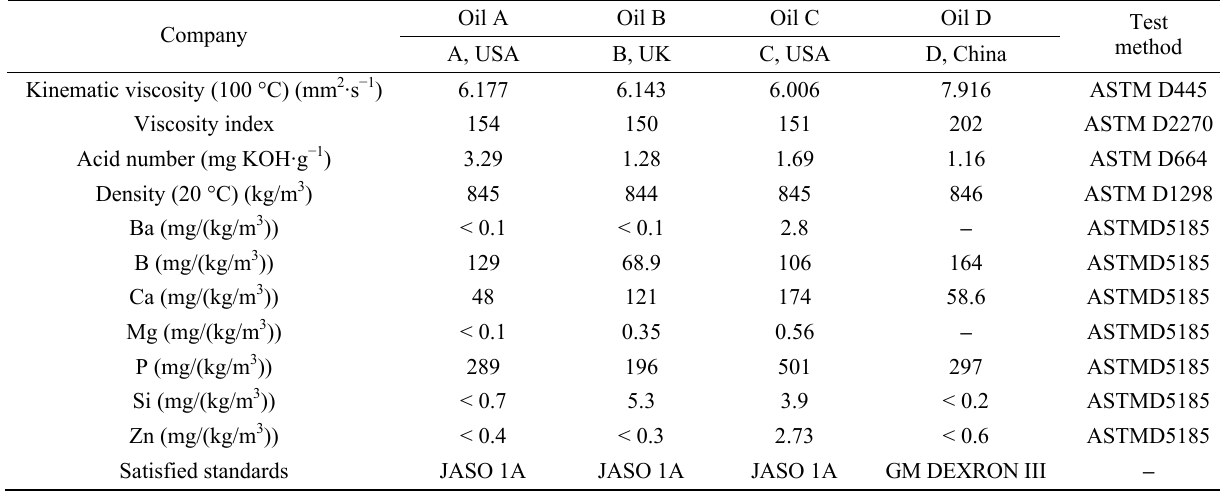
Table 1 Characteristics of ATFs A, B, C, and